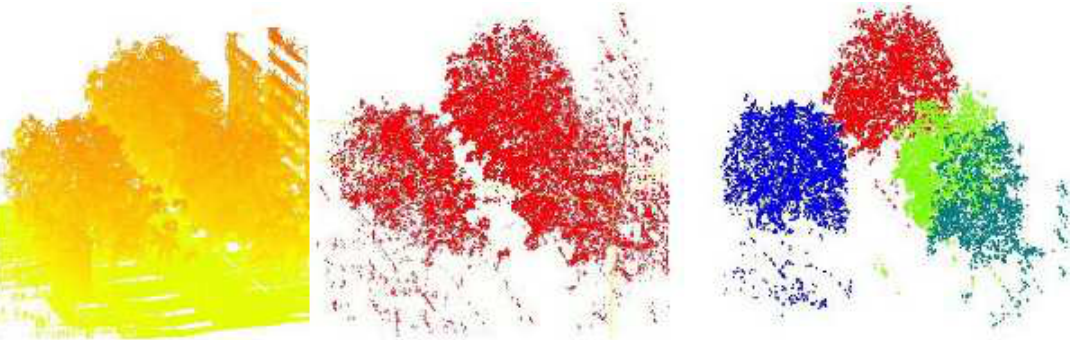
Figure 3. Left: input point cloud. Middle: points whose scatter surpasses their linearity and planarity; Right: individual tree separation results.